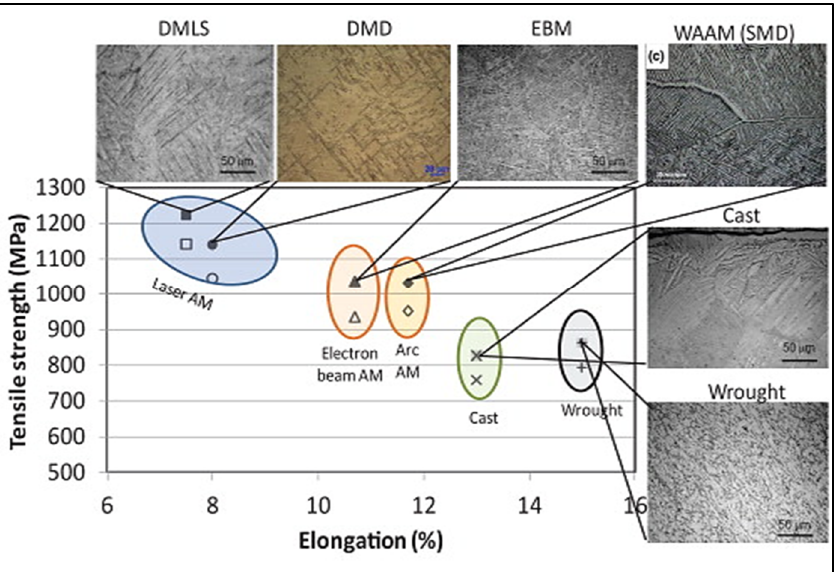
Figure 3. Microstructures and room-temperature tensile strengths of AM Ti6Al4V alloy produced us- ing various AM technologies compared with those of traditional methods. Reproduced from [17] with permission from Elsevier. (DMLS = Direct Metal Laser Sintering, DMD = Direct Metal Deposition, EBM = Electron Beam, WAAM = Wire Arc AM, SMD = Shaped metal